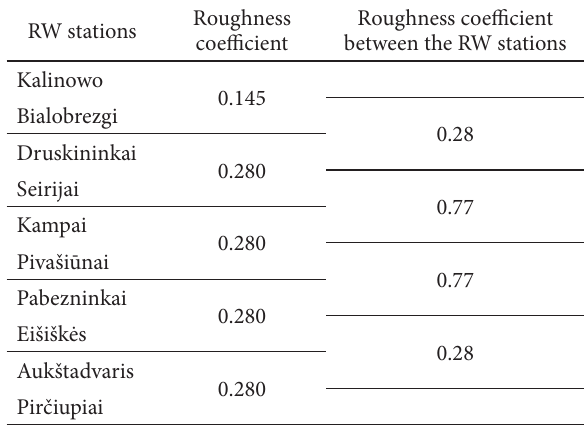
Table 3. Roughness Coefficient in each segment between the RW